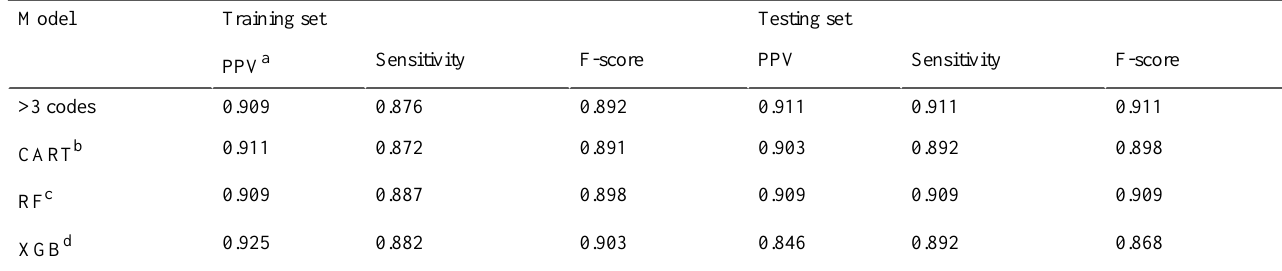
Table 3. Positive predictive value, sensitivity, and F-scores for each model to identify individuals with any organ transplant in the training and testing sets.